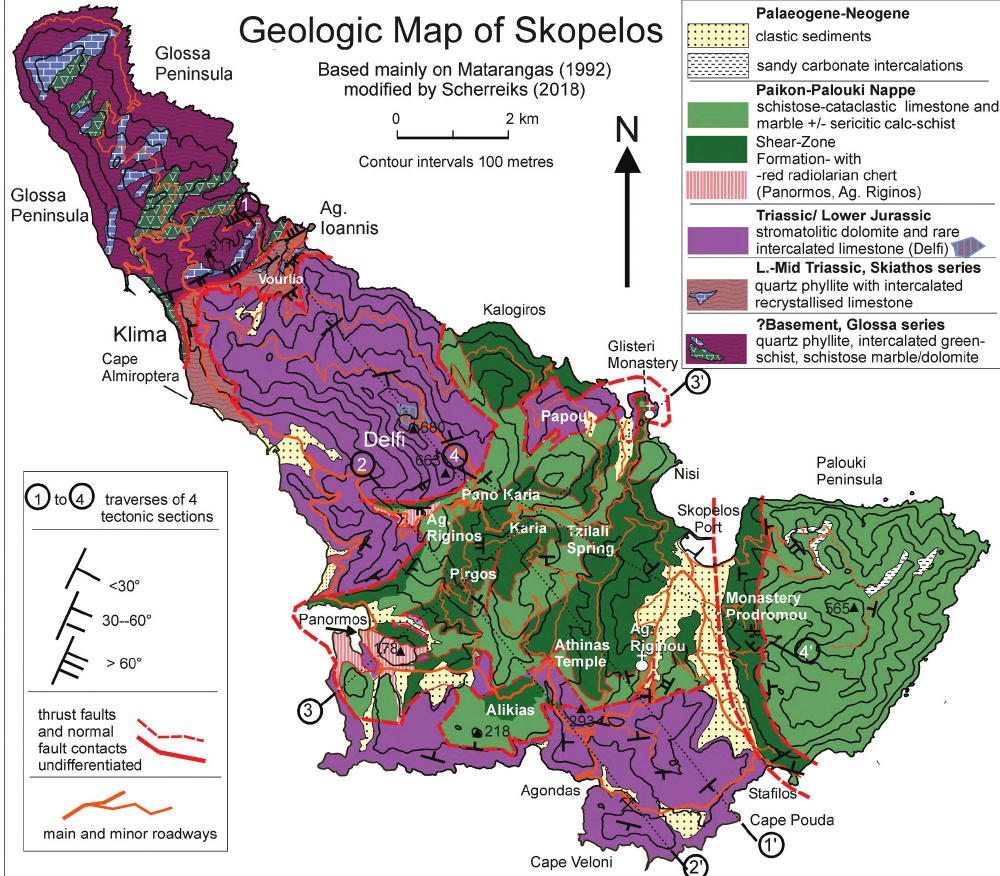
The Pelagonian formations extend stratigraphically from the pre-Middle Triassic basement (Glossa and skiathos series) to Upper Triassic/?Lower Jurassic dolomites (Mt. Delfi). The Triassic dolomite is brecciated and permeated by faults in all areas where it overlies the basement. The Eohellenic ophiolite that once covered the Pelagonian formations has been removed by erosion. a tectonically emplaced shear zone formation overlies the dolomite formation and is overlain by allochthonous Cretaceous limestones and marbles of the Paikon– Palouki nappe . These formations occur in the southern part of skopelos and also build the Palouki Peninsula. The position and traces of the tectonic sections 1–4 are indicated on the map and are shown in Fig.